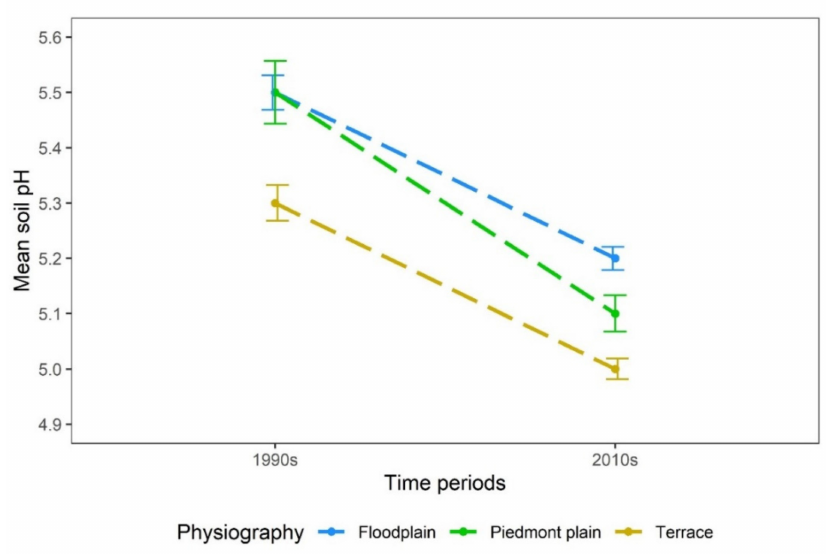
Figure 7. The effect of soil sampling collection periods (1990s, 2010s) on soil pH (0–15 cm) in the Piedmont plain, Floodplain and Terrace